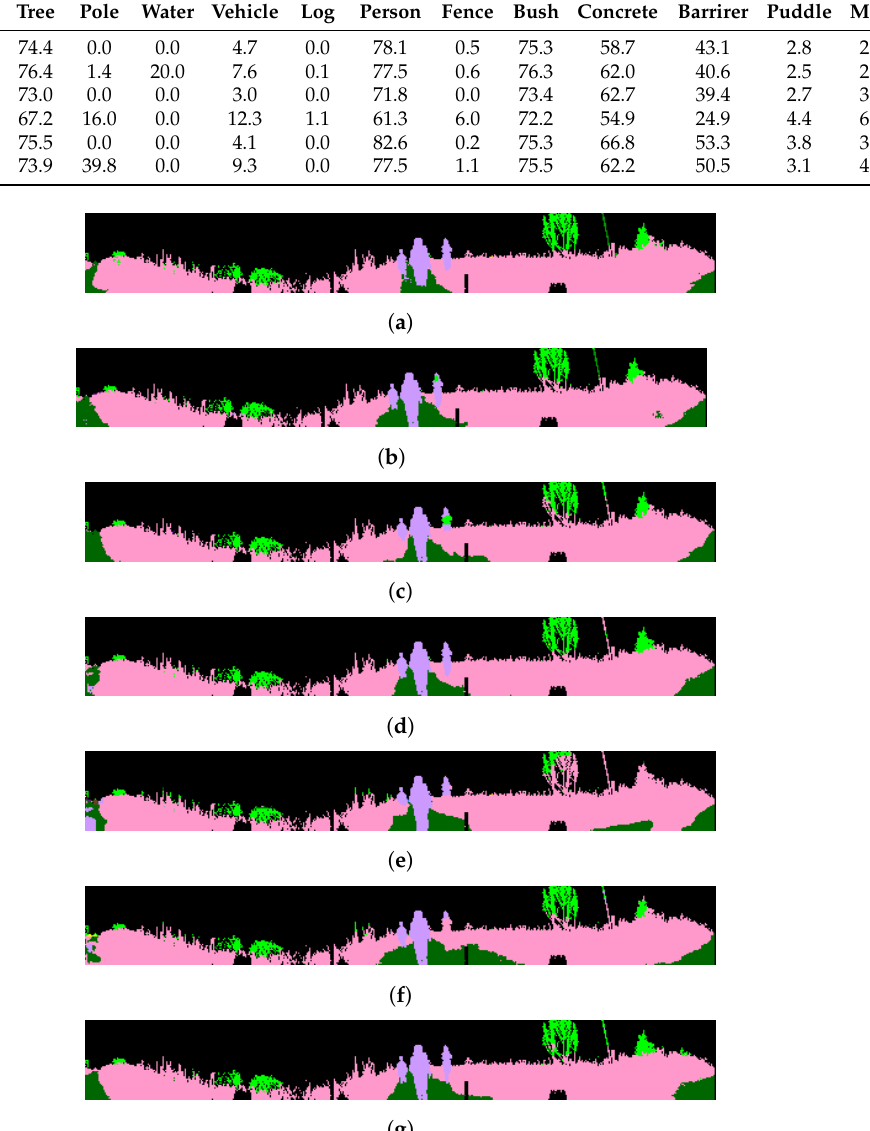
Figure 8. Qualitative results of the methods for RELLLIS-3D. ( a ) Ground Truth; ( b ) SegUNet3D; ( c ) SegNet; ( d ) U-Net; ( e ) SqueezeSegV2; ( f ) PointSeg; ( g )